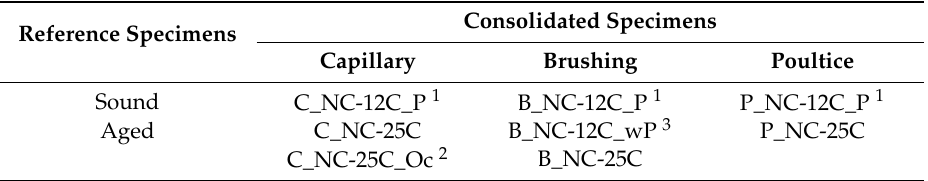
Table 1. Labelling for the studied conditions: sound and aged stone specimens as reference conditions, consolidated specimens with either NC-12C or NC-25C applied by di ff erent application techniques: capillary absorption, brushing and poultice for both lithotypes.